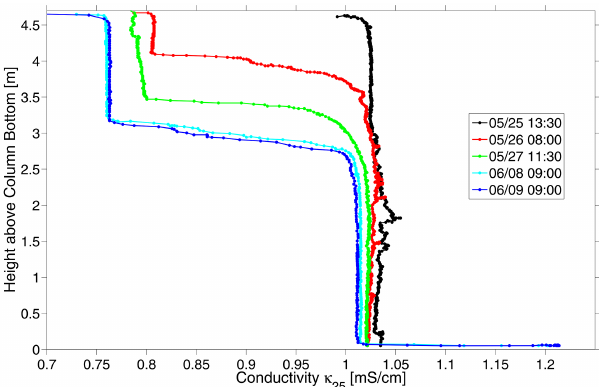
Figure 5. Selected conductivity ( κ 25 ) profiles at different time steps of the lab experiment. The earliest profile shows the initial condition in the water column followed by two profiles during active aeration at a depth of 0.5 and 1m, respectively. Last two profiles show the conductivity distribution in the column a certain time after cessation of